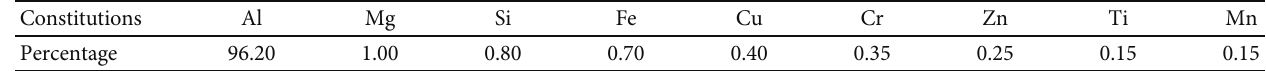
Table 1: Chemical constitutions of AA6061 alloy.